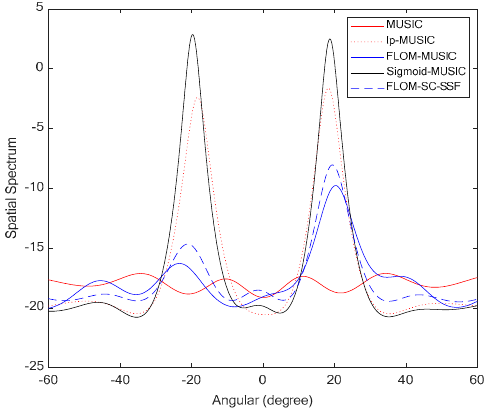
Figure 6. Spatial spectra of the four algorithms.